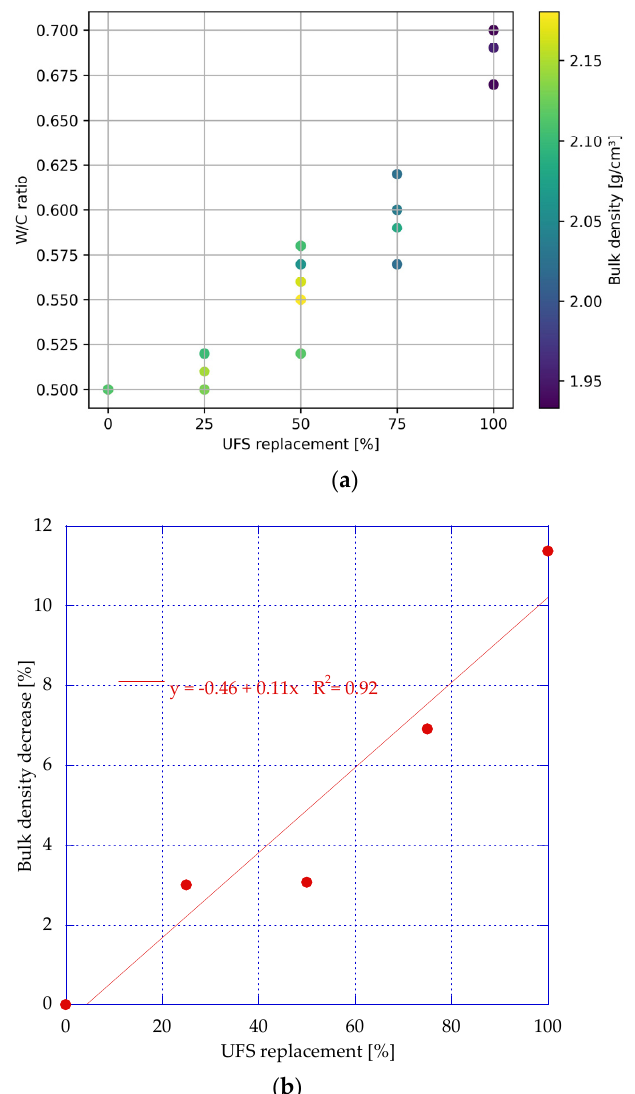
Figure 11. Bulk density of the mortar mixes (g/cm 3 ) ( a ) and bulk density decrease (%) ( b ).